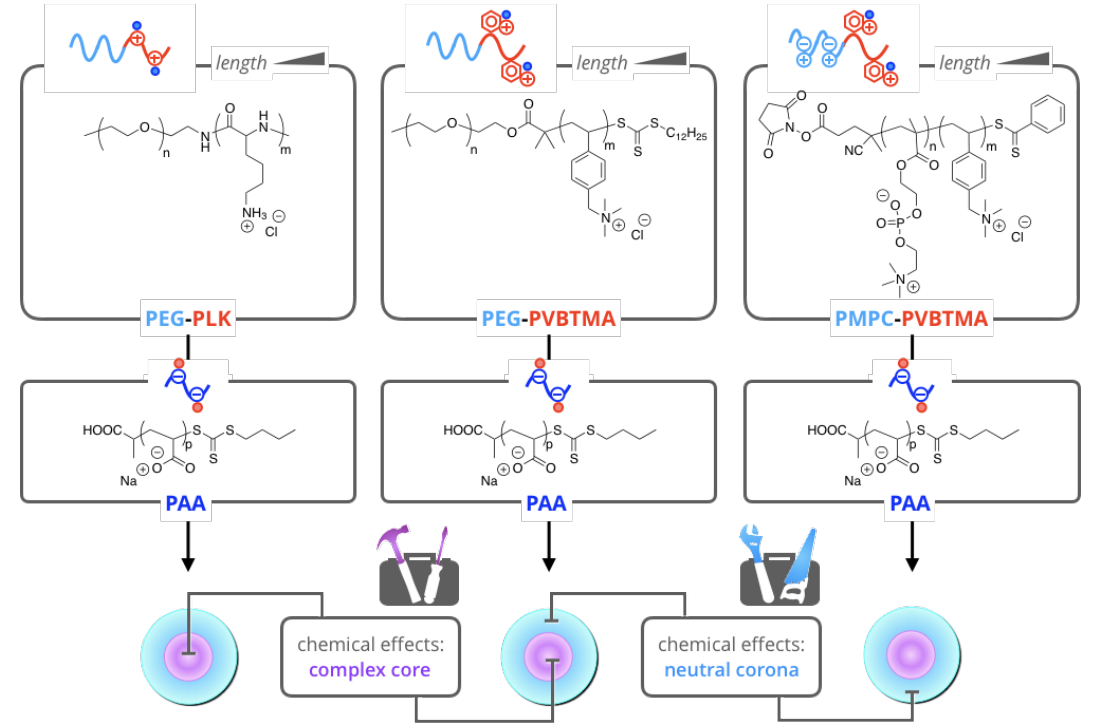
Figure 1. Chemical structures of polyelectrolytes and illustration of the rational pairings to investigate the chemical effects of the complex core and neutral corona in polyelectrolyte complex micelles. Diblock polycations include poly(ethylene glycol)- block -poly(l-lysine) (PEG-PLK), poly(ethylene glycol)- block -poly((vinylbenzyl)trimethylammonium chloride) (PEG-PVBTMA) and poly(2-methacryloyloxyethyl phosphorylcholine methacrylate)- block -poly(vinylbenzyl)trimethylammonium chloride) (PMPC-PVBTMA). Poly(sodium acrylate) (PAA) was used as the polyanion for all cases. See Table 1 for polymer length and characterization. Table 1. Summary of polymer